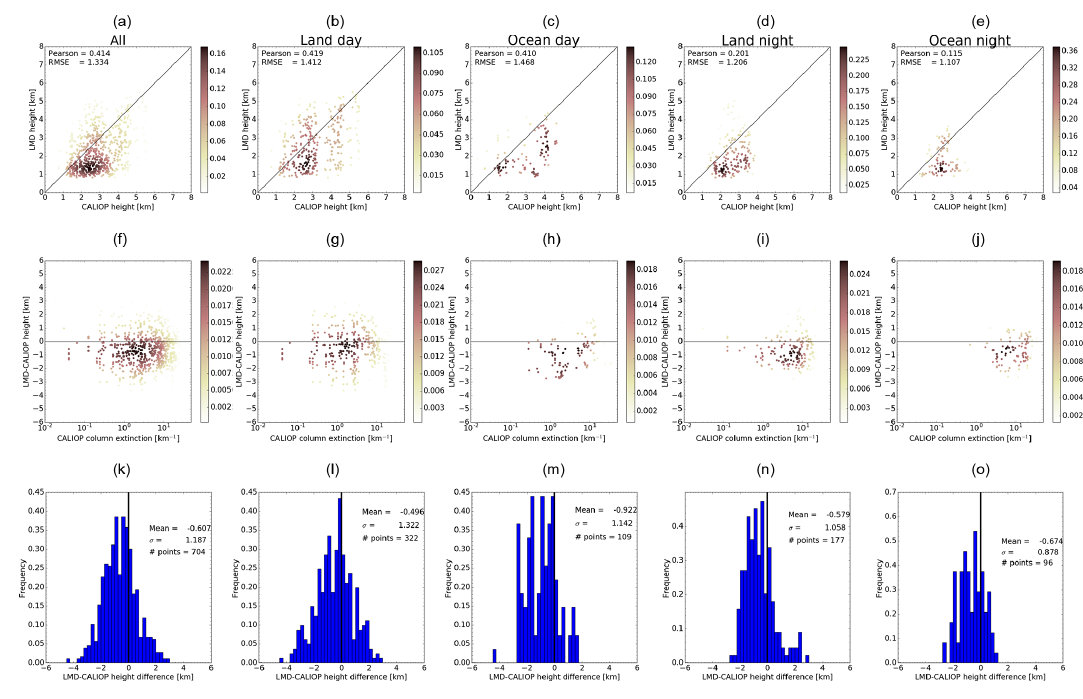
Figure A3. Similar to Fig. A1 but for the LMD algorithm.